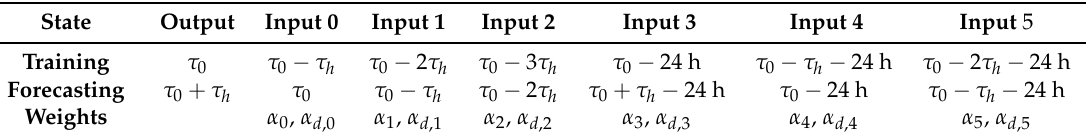
Table 1. List of time lags τ i and weights α in the forecasting model. Note that the subindex “d” runs along all the tangent spaces listed in List dist